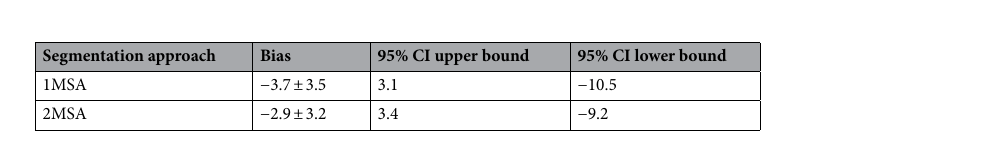
Table 6. Bland–Altman plots statistics by segmentation approach for pooled study 5 and study 6 a . a Represented as MD ± standard deviation.